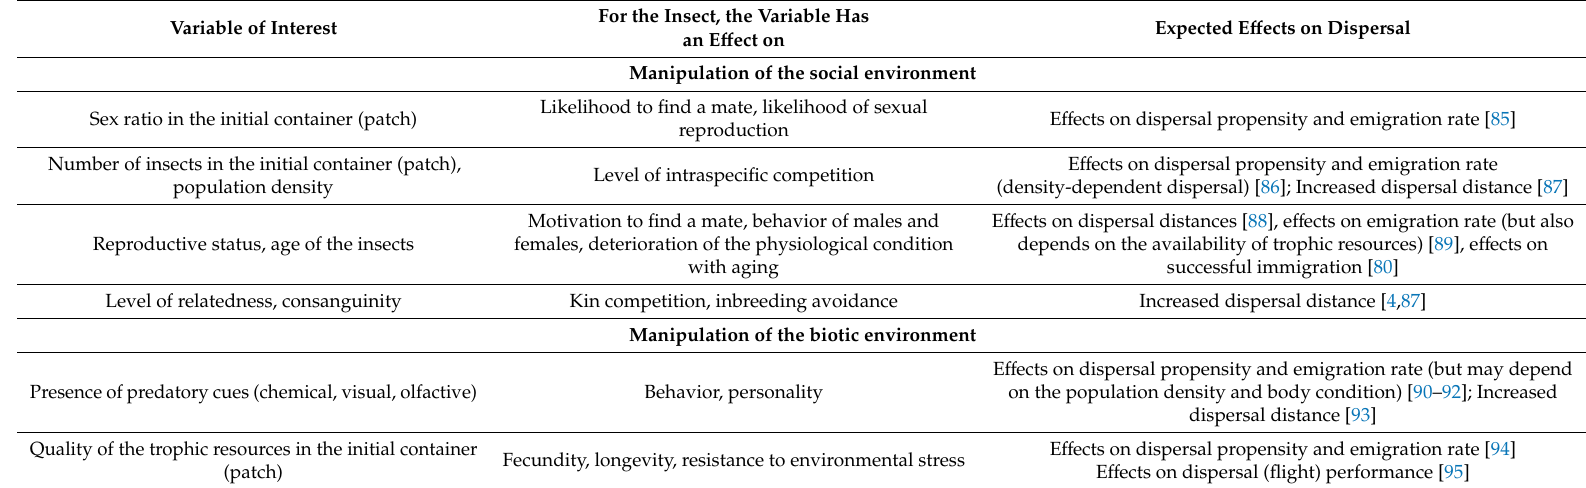
Table 2. Overview of potential manipulations of the environment of interest in experimental studies of insects’ dispersal. Some of the conditions can be manipulated to test the e ff ects of prenatal and postnatal habitat conditions. For the tested insects, the knowledge of their foraging area (routine movements) is particularly helpful, even if this information might be di ffi cult to obtain. Tentative predictions of possible e ff ects of the conditions on individuals’ phenotypes and dispersal are illustrated with published